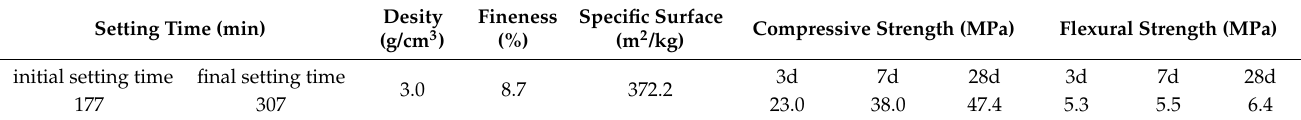
Table 1. Physical properties of